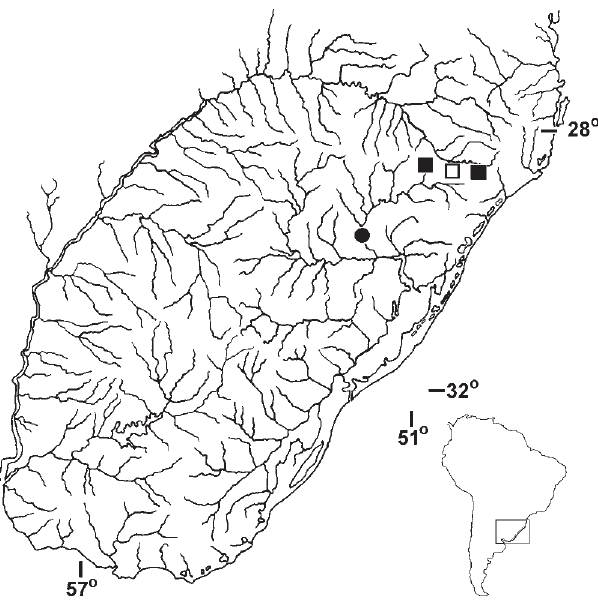
Fig. 2 . Distribution of the new species of Bryconamericus - B . patriciae (squares, open square is type-locality) and B.